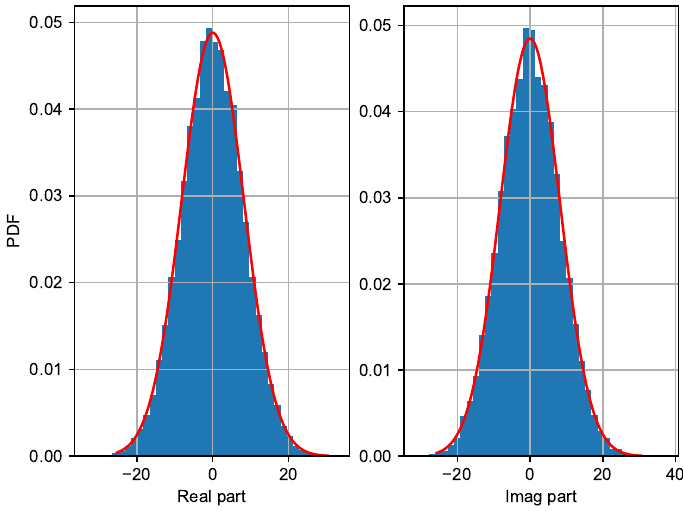
Figure 9. Empirical PDFs of real and imaginary parts of the system noise (Blue), and matching normal distributions